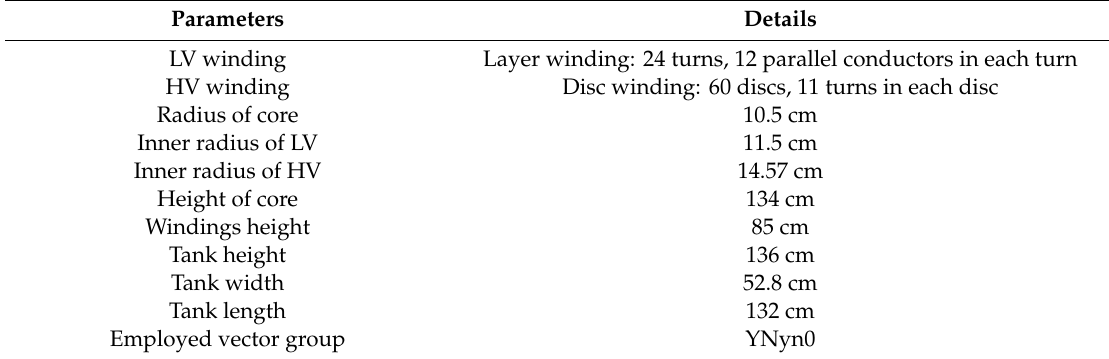
Table A1. Geometrical dimensions of the three-phase